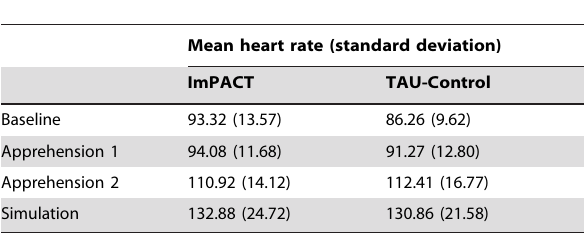
Table 2. Average heart rate before and during all phases of the live simulation (Day 5 of the